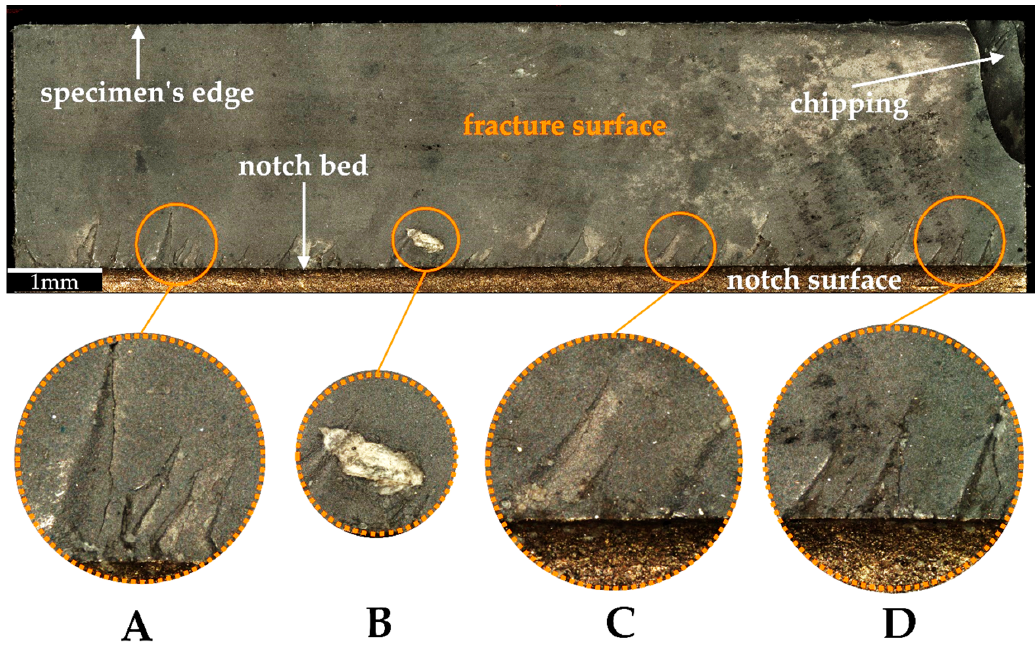
Figure 7. Microscopic view of the fracture surface after impact test with ( A – D ) sections indicated.